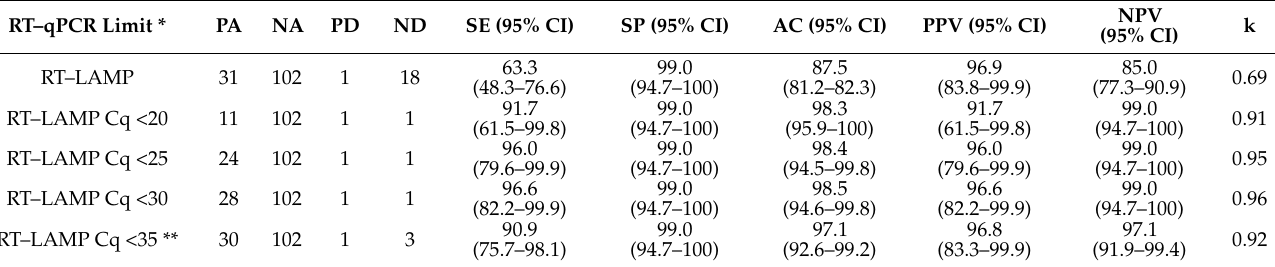
Figure 3. Detection probability of the fluorescence-based RT-LAMP for all the targets ( a ). The results of the probit analysis is shown in ( b ) for ORF8, ( c ) for ORF3a, and ( d ) for N. Graphs generated with MedCalc. Table 2. Clinical evaluation of the